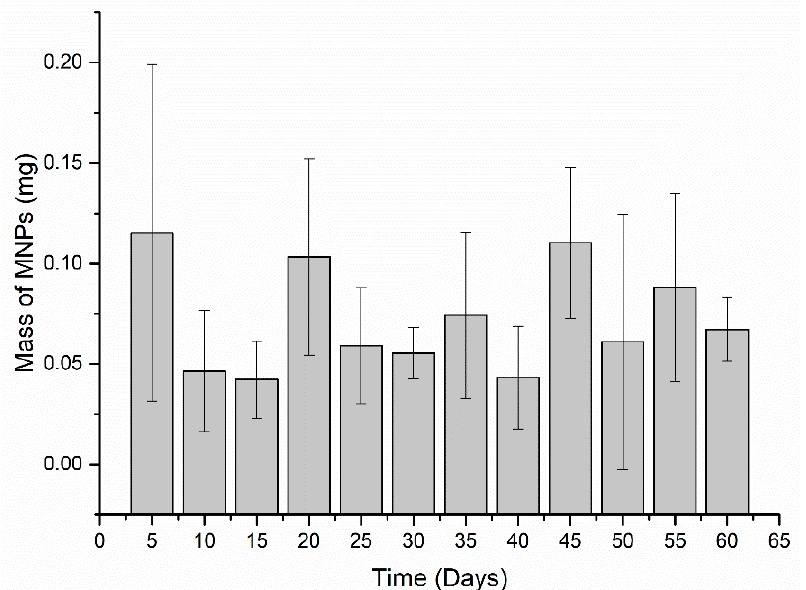
Figure 4. Elimination of MNPs via feces every five days. For statistical analysis, the Mann–Whitney U test was used. It was found no significant difference between the days ( p < 0.05).